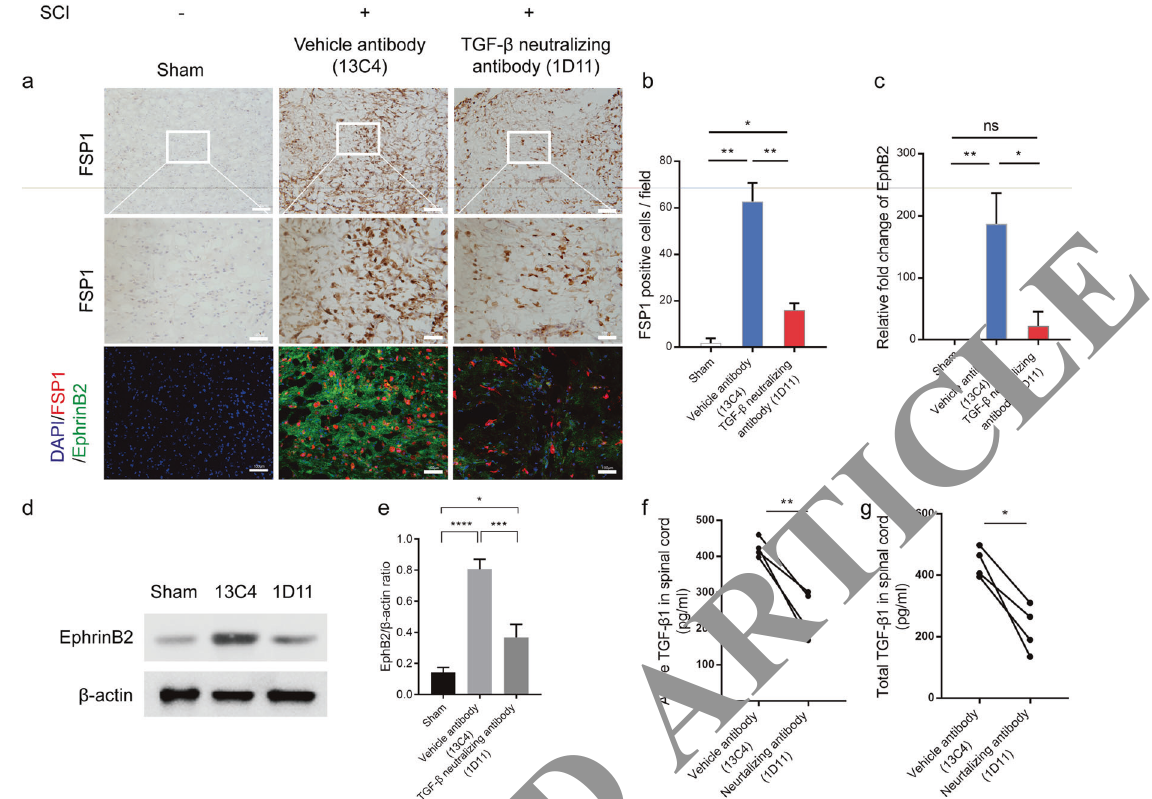
Fig. 1 Fibroblast secreting and EphrinB2 expression are inhibited in TGF- β knockout mice. a Representative images of Immunohistochemistry and immuno fl uorescence analysis of FSP1 (red), EphrinB2 (green) and DAPI (blue) in each group at 2 weeks after SCI. Scale bars = 100 μ m. Images on the middle row are high-resolution versions of the boxed regions in the top images, scale bars = 25 µm. b , c Quantitative analysis of FSP1 positive cells/ fi eld and relative fold change of EphrinB2 (* p < 0.05, ** p < 0.01, n = 4). d Representative western blots showing the expression of EphrinB2 indifferent groups in vivo. e Quantitative analysis of the EphrinB2/ β -tublin ratio in different groups mice after SCI (* p < 0.05, *** p < 0.001, **** p < 0.0001, n = 3). f , g Elisa analysis showing the concentration of TGF- β in spinal cord after SCI between 13C4 group control mice and 1D11 group mice (* p < 0.05, ** p < 0.01, n =